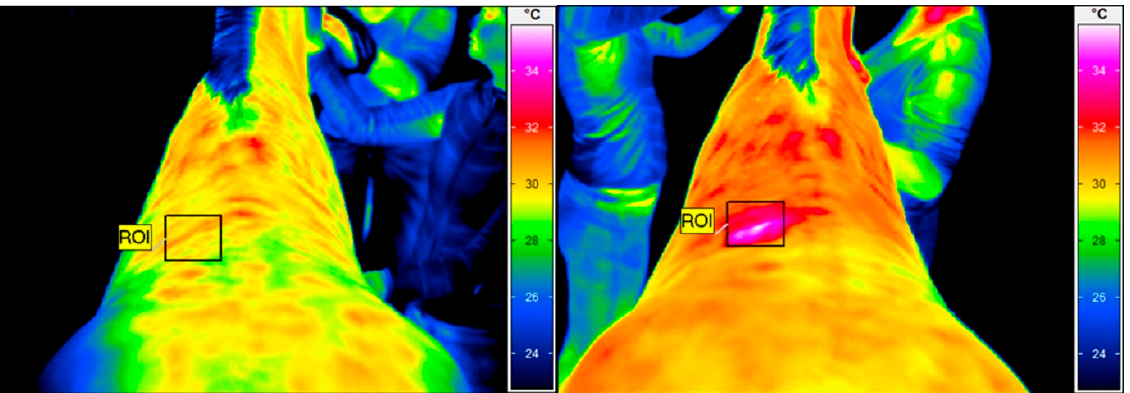
Figure 1. Thermographic images of the thoracolumbar back region. The square area (ROI) indicates the skin surface temperature before HILT (left), with an average temperature of 29.8 °C, and immediately after (right), with an average temperature of 32.9 °C.